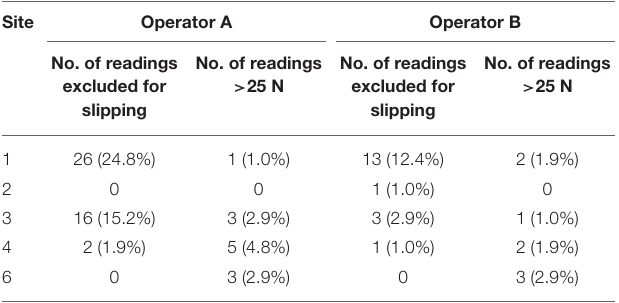
TABLE 1 | MNT readings taken from the thoraces of calves that exceeded the 25N upper limit of the pressure range used in this study, or that were excluded for probe slippage during testing.